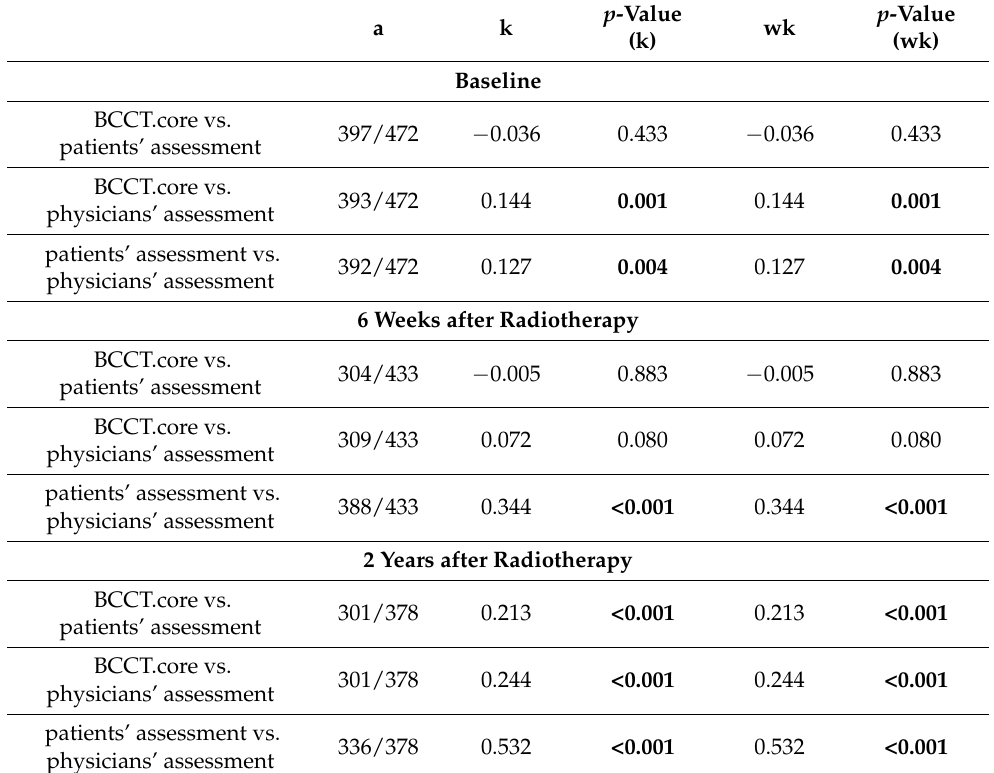
Table 5. Agreement of the BCCT.core software results with patients’ or physicians’ assessment scores, and agreement of patients’ assessment scores with physicians’ assessment scores, at the baseline, 6 weeks, and 2 years after radiotherapy (two-point scale: